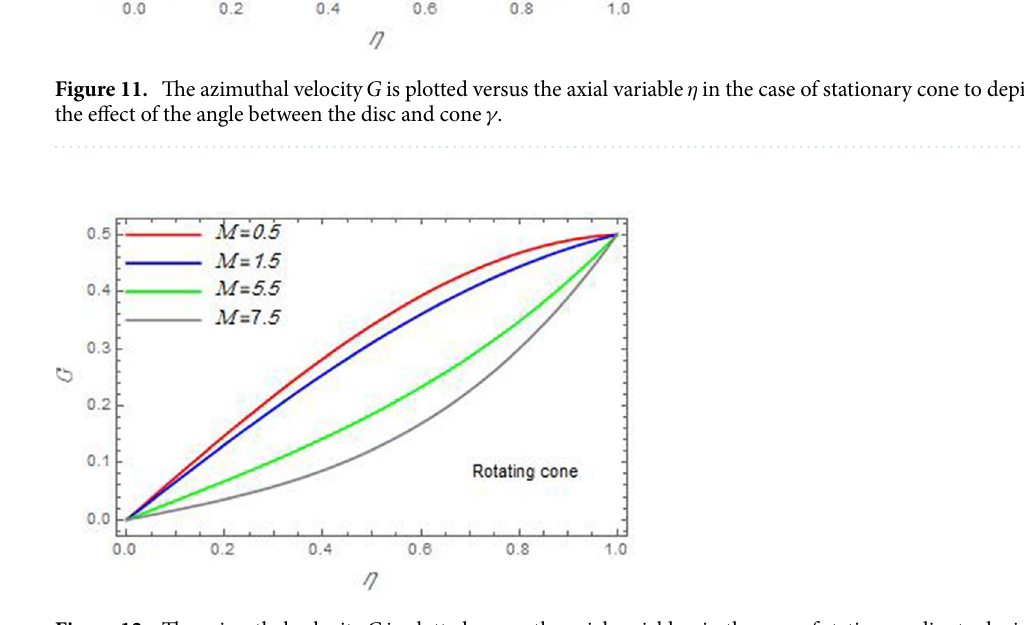
Figure 12. The azimuthal velocity G is plotted versus the axial variable η in the case of stationary disc to depict the effect of the magnetic parameter M